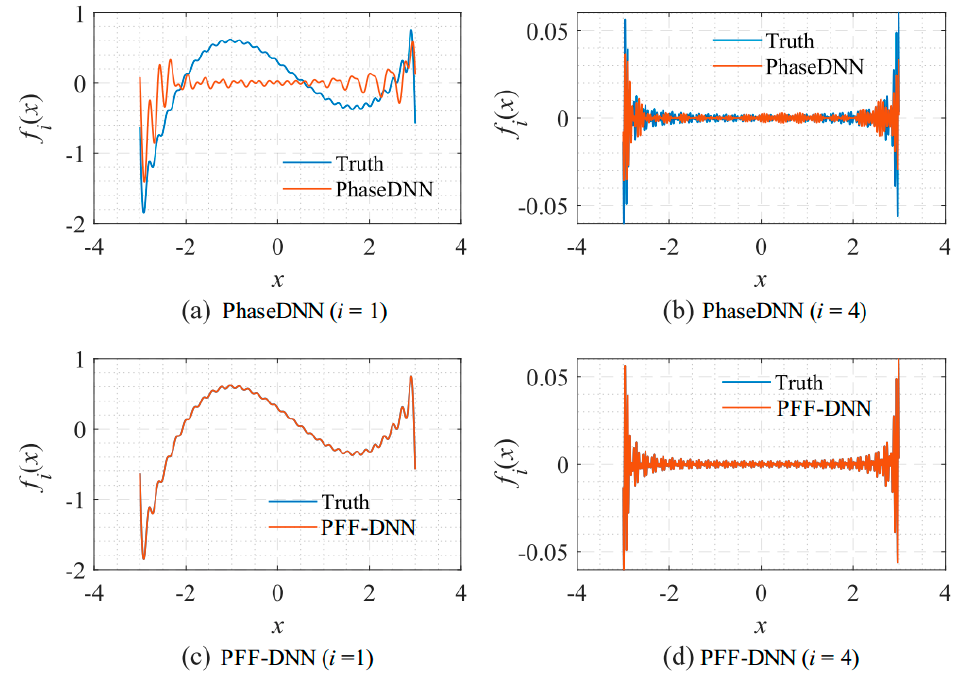
Figure 7. Comparison between the fitting results of the PhaseDNN and PFF-DNN methods for different frequency bands. The fitting results after neural networks were updated 5000 times given ∆ ω = 31: ( a ) first frequency band (PhaseDNN); ( b ) fourth frequency band (PhaseDNN); ( c ) first frequency band (PFF-DNN); and ( d ) fourth frequency band (PFF-DNN).